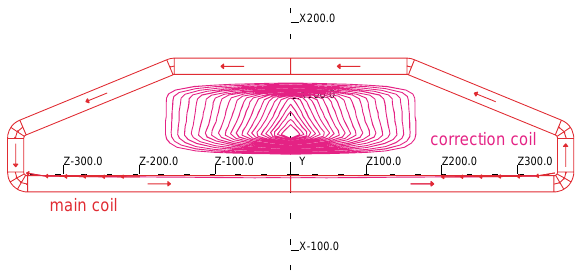
FIG. 4. (Color) Surface correction coils for the upper pole of a 90 ± HDSM bending